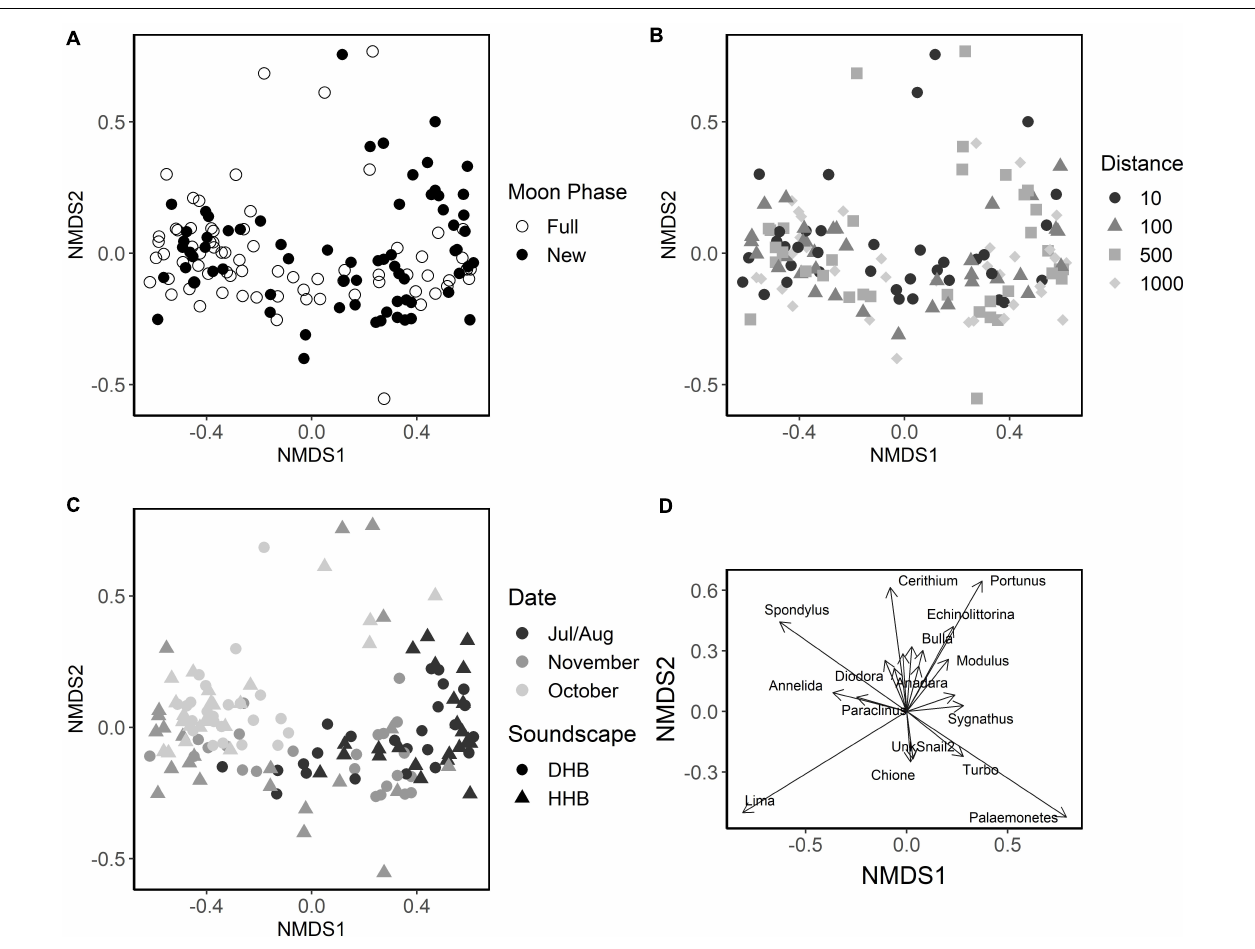
FIGURE 6 | Non-metric Multidimensional Scaling ordination of larval assemblage samples. Each point represents the larval assemblage found on an individual collector. (A) Collector points shaded by the moon phase during collection (open circle = full moon, closed circle = new moon). (B) Shapes indicate the distance of the collector from the playback device (circle = 10 m, triangle = 100 m, square = 500 m, and diamond = 1,000 m). (C) Collector points colored by collection period (black = July/August, dark gray = October, light gray = November) and shape indicates the broadcasted soundscape (circle = degraded hardbottom, triangle = healthy hardbottom). Each collection period includes one full and one new moon sampling session. (D) Plot of influential species vectors, lengths are scaled by their correlation so that strong predictors have longer arrows than weak